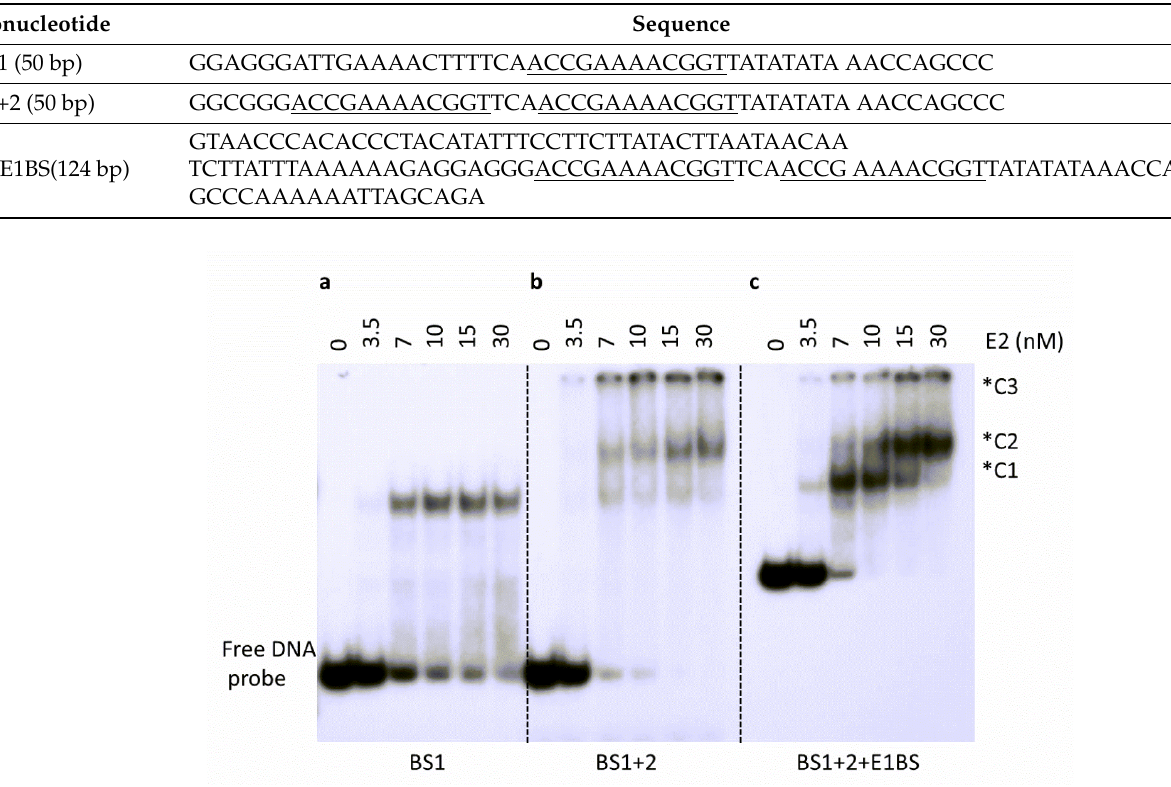
Table 3. Sequences of oligonucleotides utilized in multi-site DNA binding assays. Sequences for only one strand of each duplex oligonucleotide are shown. E2 binding sites (BS1 and BS2) are underlined and bolded.